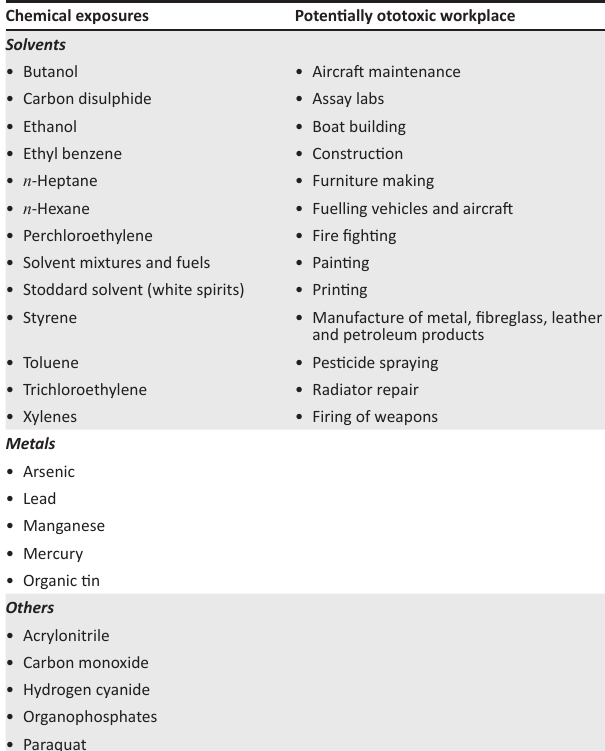
TABLE 1: Lists of chemical exposures and workplaces that are potentially